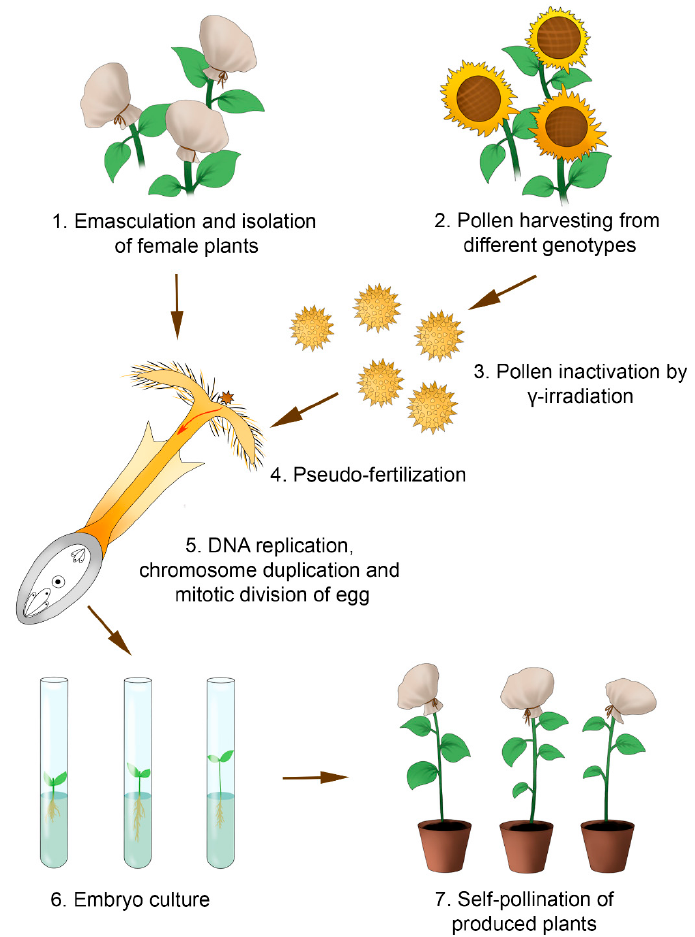
Figure 4. Stages of induced parthenogenesis of sunflower using γ -irradiated pollen.